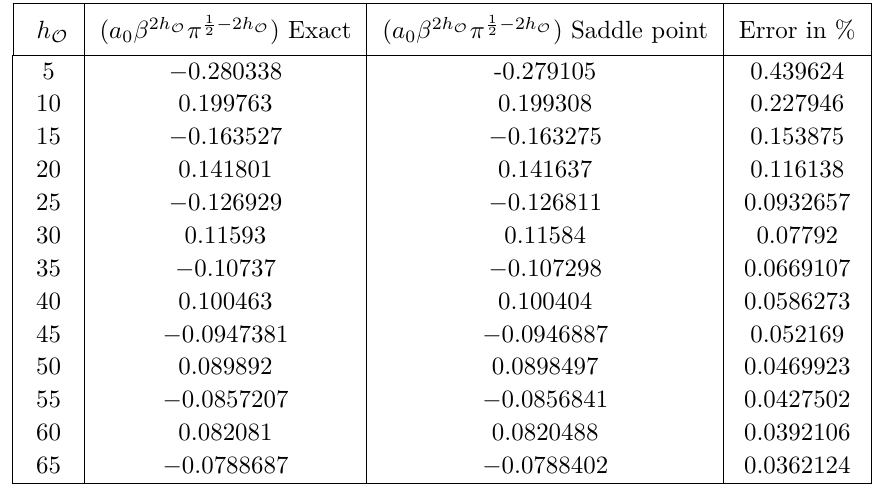
Table 1 . Numerical comparison of the exact value of the residue at integer h O against the saddle point given in